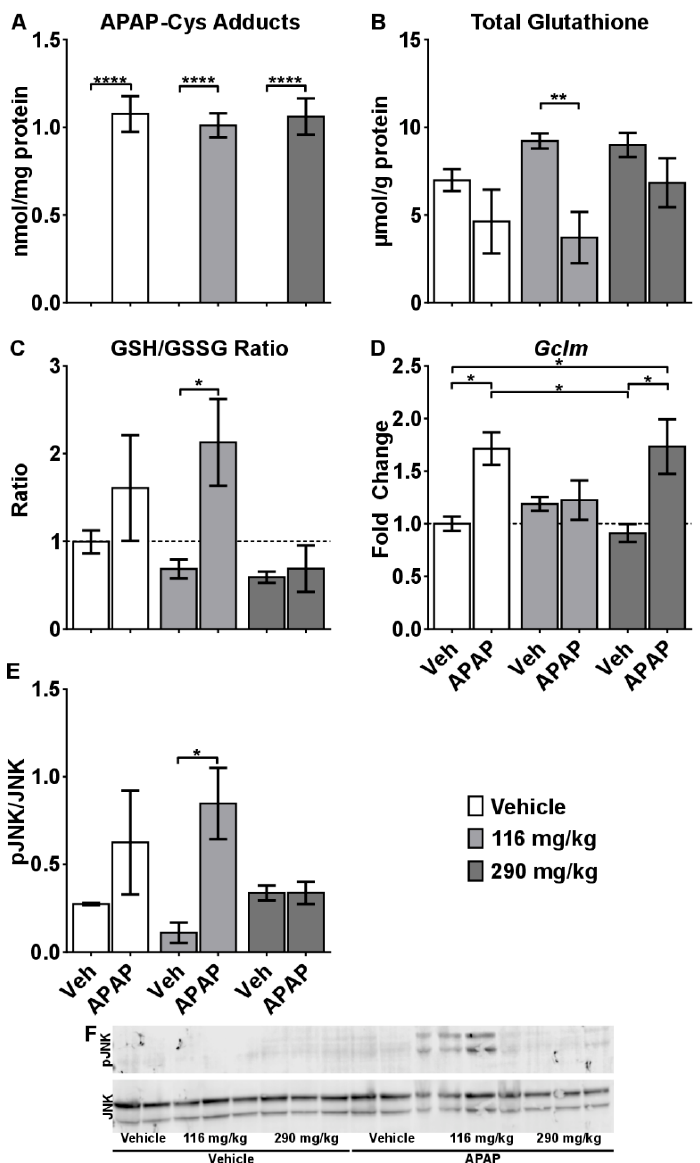
Figure 4. Mechanisms of CRCE/APAP-induced liver injury. ( A ) APAP-Cys protein adducts; levels